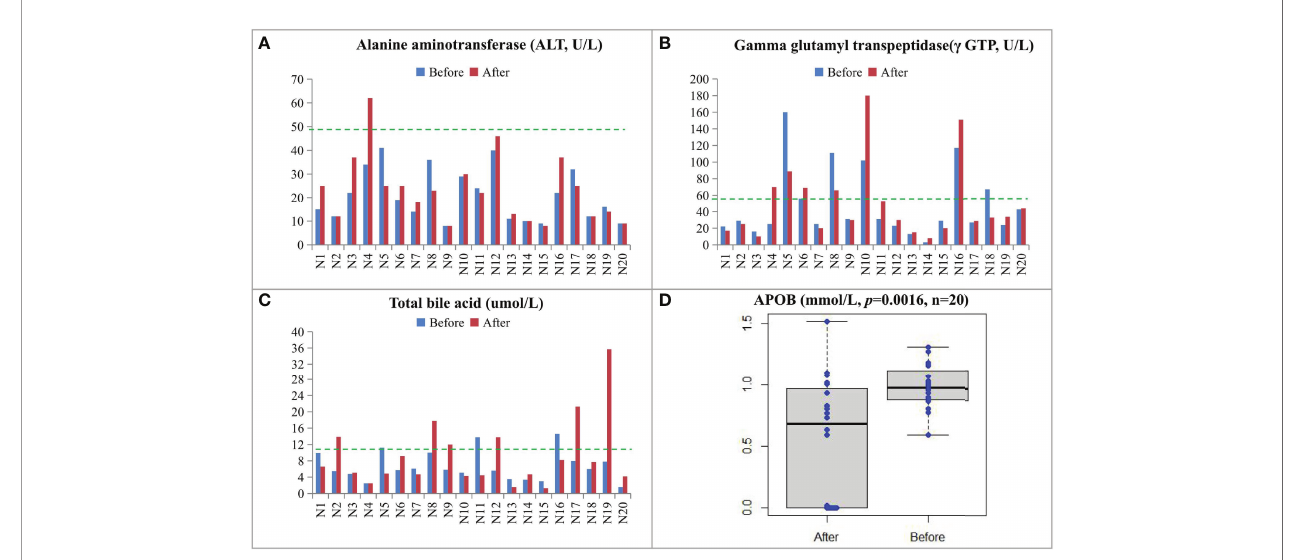
FIGURE 1 | Biochemical examinations and lipid measurements of CRC patients before and after treatment including ALT (A) , g GTP (B) , total bile acid (C) , and APOB (D) . The upper limit of normal level for each item was labeled by a green line.